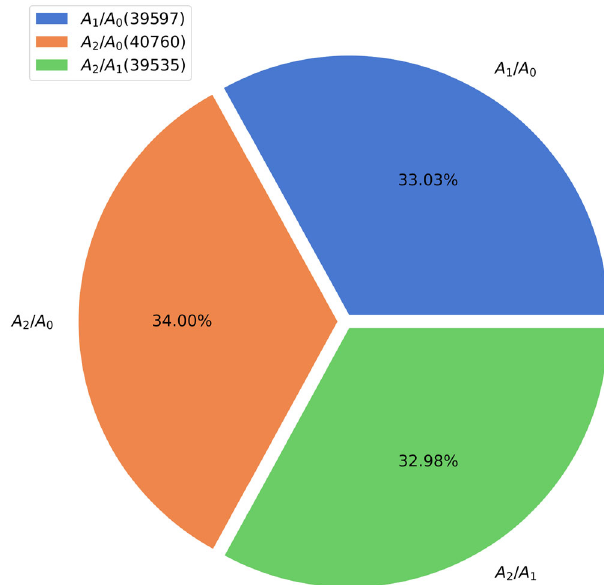
Fig. 5 Each of the three ratios contributed about equally to the improved estimations of the monoisotopic RIA. The pie chart shows the percentages of data points for which the estimations of labeling enrichment from each ratio type were optimal. For 34% (~61000 data points) of improved estimations of the label enrichments, the improvements were achieved by using A 2 (t)/A 0 (t)